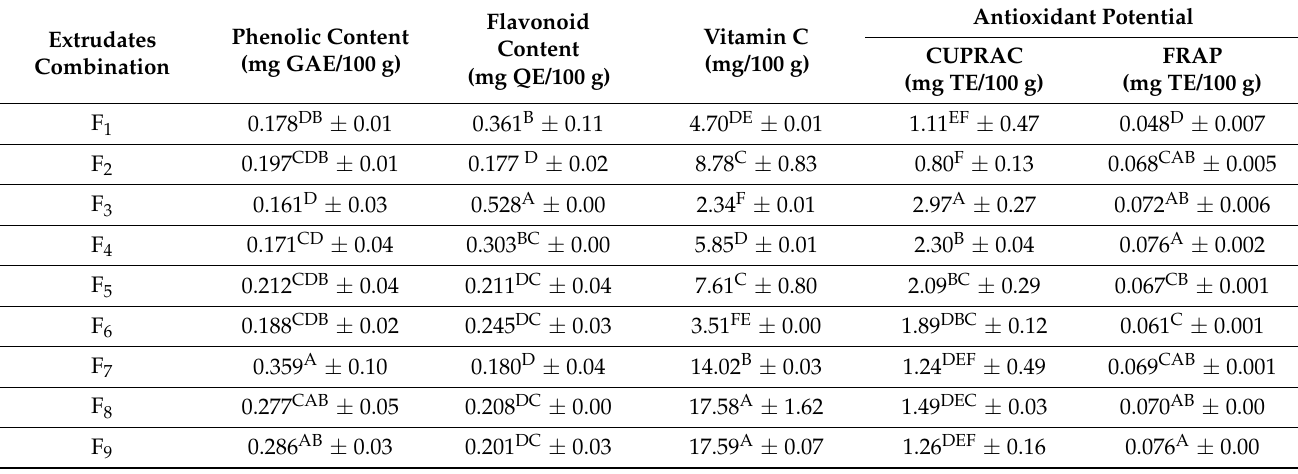
Table 10. Phenolics, flavonoids, vitamin C and antioxidant properties of neera honey based